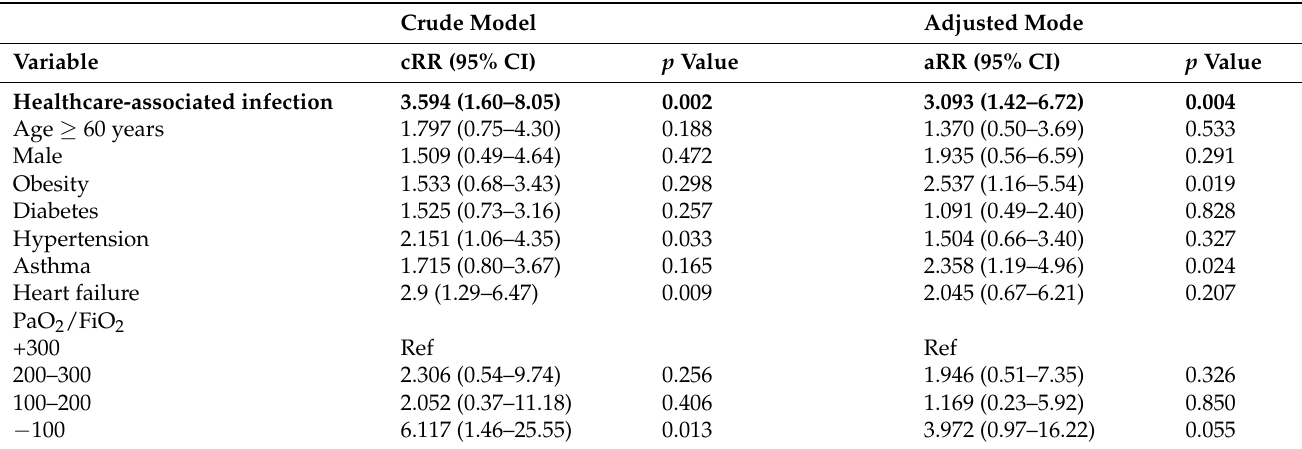
Table 5. Poisson regression analysis to evaluate risk factors for acute kidney injury in patients hospitalized for critical